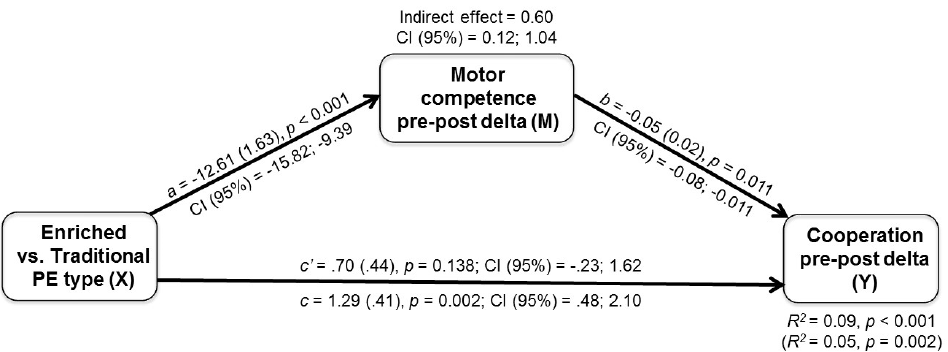
Figure 7. Mediation model: effect of PE intervention type (‘X’: enriched vs. traditional) on pre-to-post change in peer-rated cooperation skill (‘Y’) mediated by pre-to-post change in motor skill competence (‘M’). a, b, c: regression coefficients with (SE), p and CI (95%) values. c: total effect; c’: direct effect after accounting for the mediator. R 2 values with/(without mediator) and bootstrap CI (95%) for indirect effects are also reported.